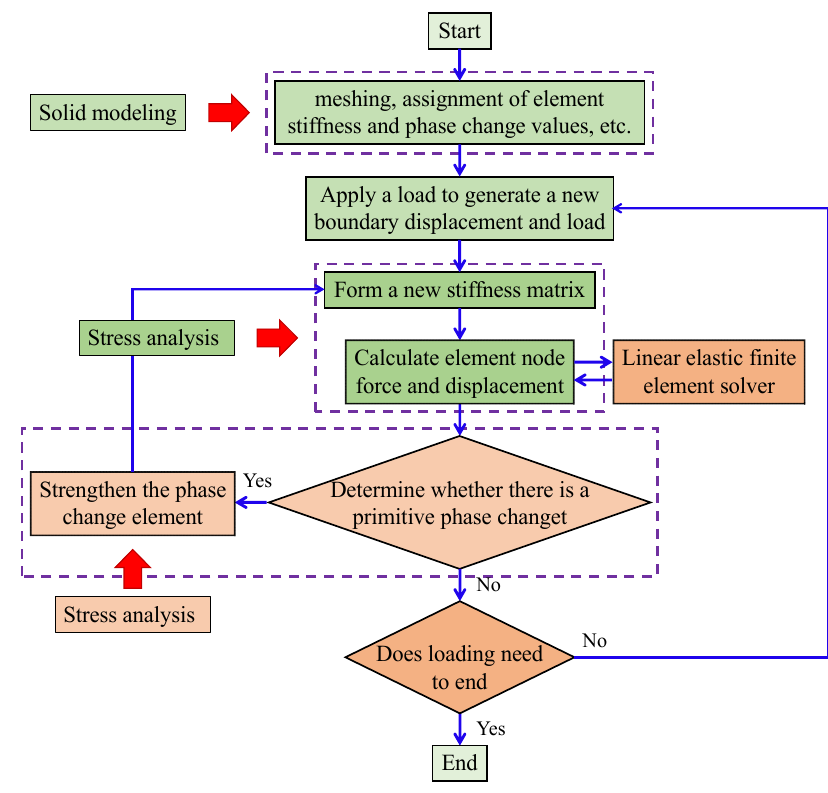
Figure 5. Failure processes and characteristics of specimens.